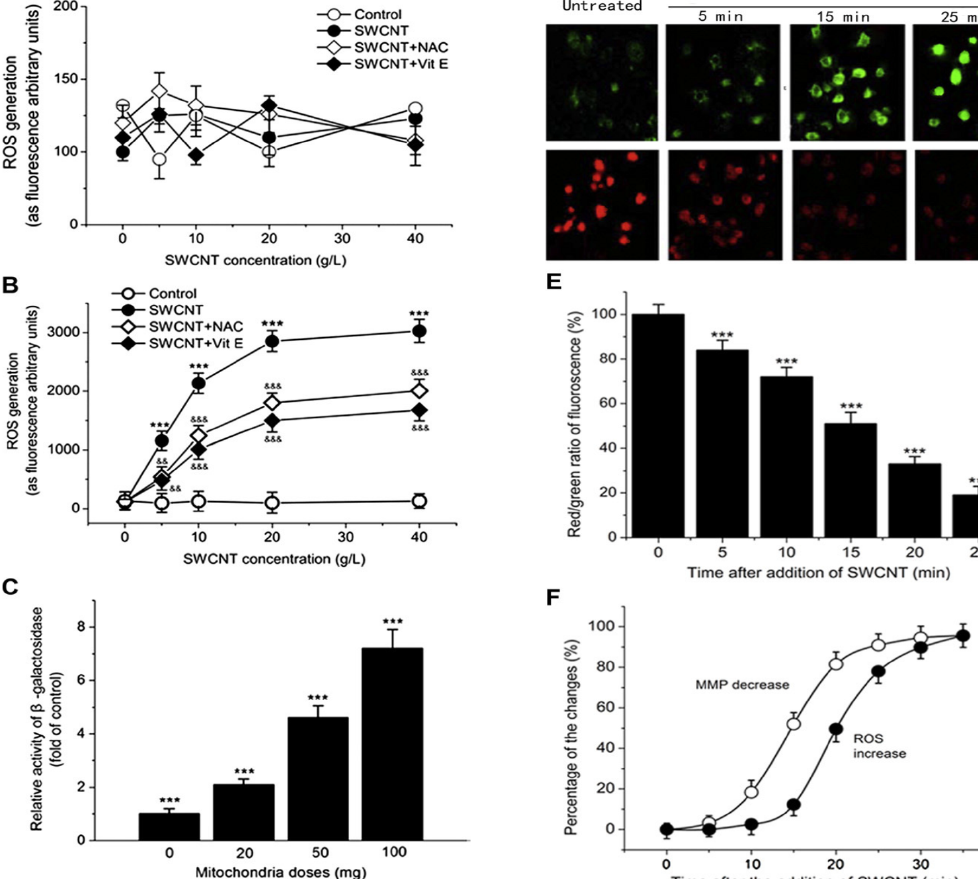
Figure 4. In vitro examination of the relationships between lysosomal and mitochondrial damage. ( A ) Effects of SWCNTs on the production of reactive oxygen species (ROS) in lysosomes. ( B ) Effects of SWCNTs on the production of ROS in mitochondria. NAC, N-acetylcysteine (10 µ mol L − 1 ); Vit E, vitamin E (10 µ mol L − 1 ). *** p < 0.001 compared with control. &&& p < 0.001 compared with SWCNT. && p < 0.01 compared with SWCNT. ( C ) The influence of mitochondria on the lysosomal damage by SWCNTs. Mitochondria were added at the indicated concentrations, and the activities of β -galactosidase were measured. Lysosomal damage was expressed as the activity of the β -galactosidase leaked from lysosomes. *** p < 0.001 compared with control. ( D ) Fluorescence images showing the influences of SWCNTs on the mitochondrial membrane potential (MMP). Green fluorescence increased and red fluorescence decreased with incubation time. ( E ) Changes in the red-to-green fluorescence ratios in the mitochondrial membranes over 25 min of incubation with SWCNTs. SWCNTs significantly decreased the ratio time-dependently. ( F ) The time courses for the changes of both MMP and mitochondrial ROS production. (Reprinted with permission from [77]. Copyright 2010, Yang et